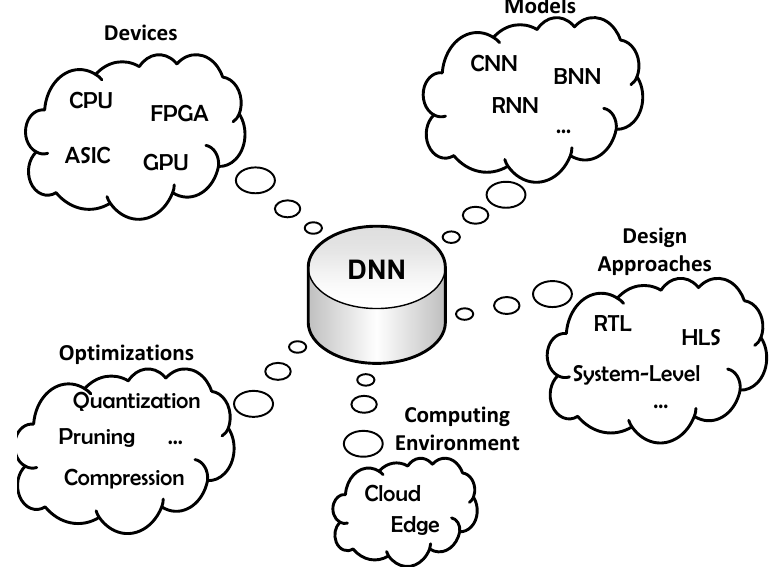
Figure 1. Design space in the development of accelerators for deep neural